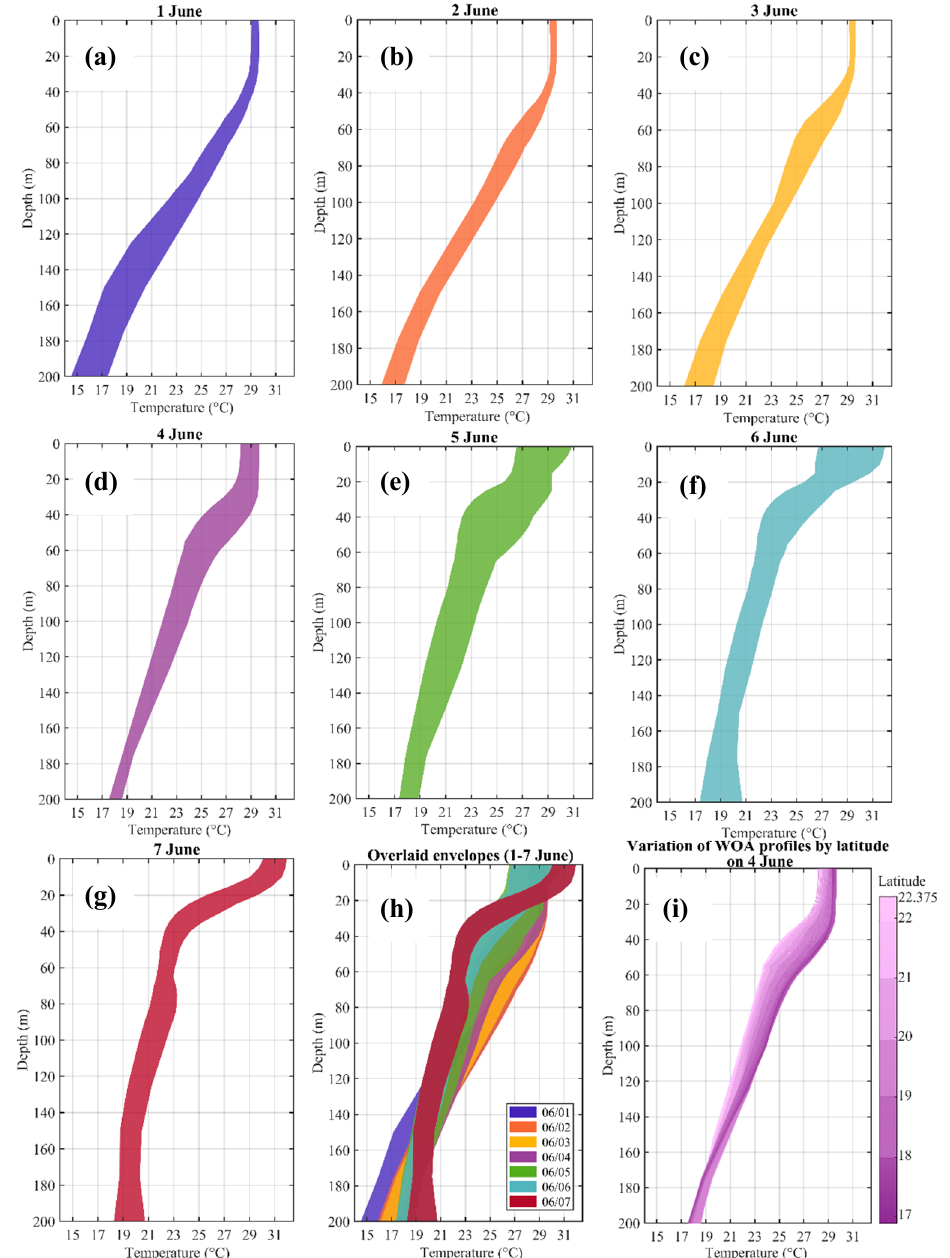
Figure 11. Envelopes of climatological profiles for each date: ( a – g ) 1–7 June, ( h ) overlayed envelopes, ( i ) latitudinal change of profiles on 4 June.